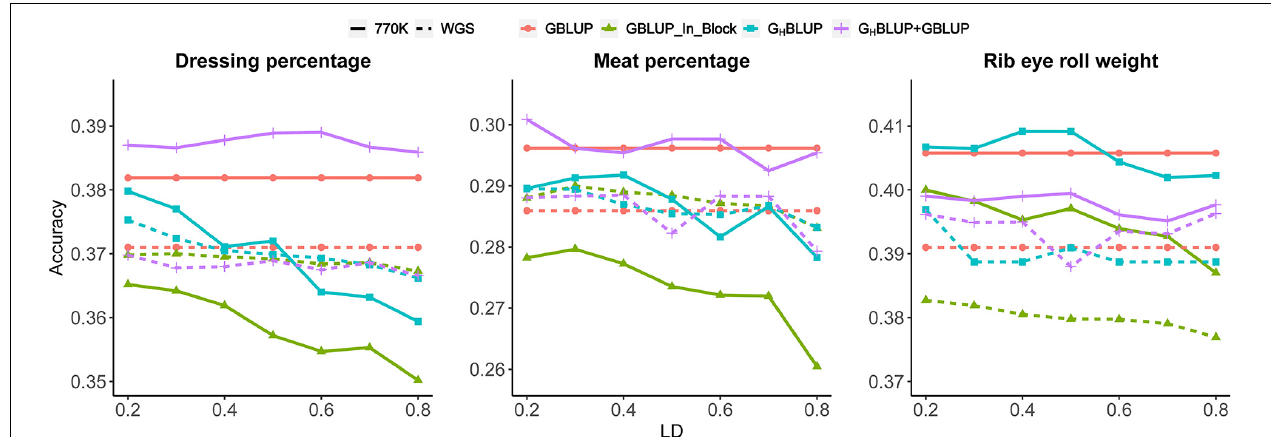
FIGURE 1 | Prediction accuracies of different r 2 thresholds for three traits based on the 770K data and WGS data.